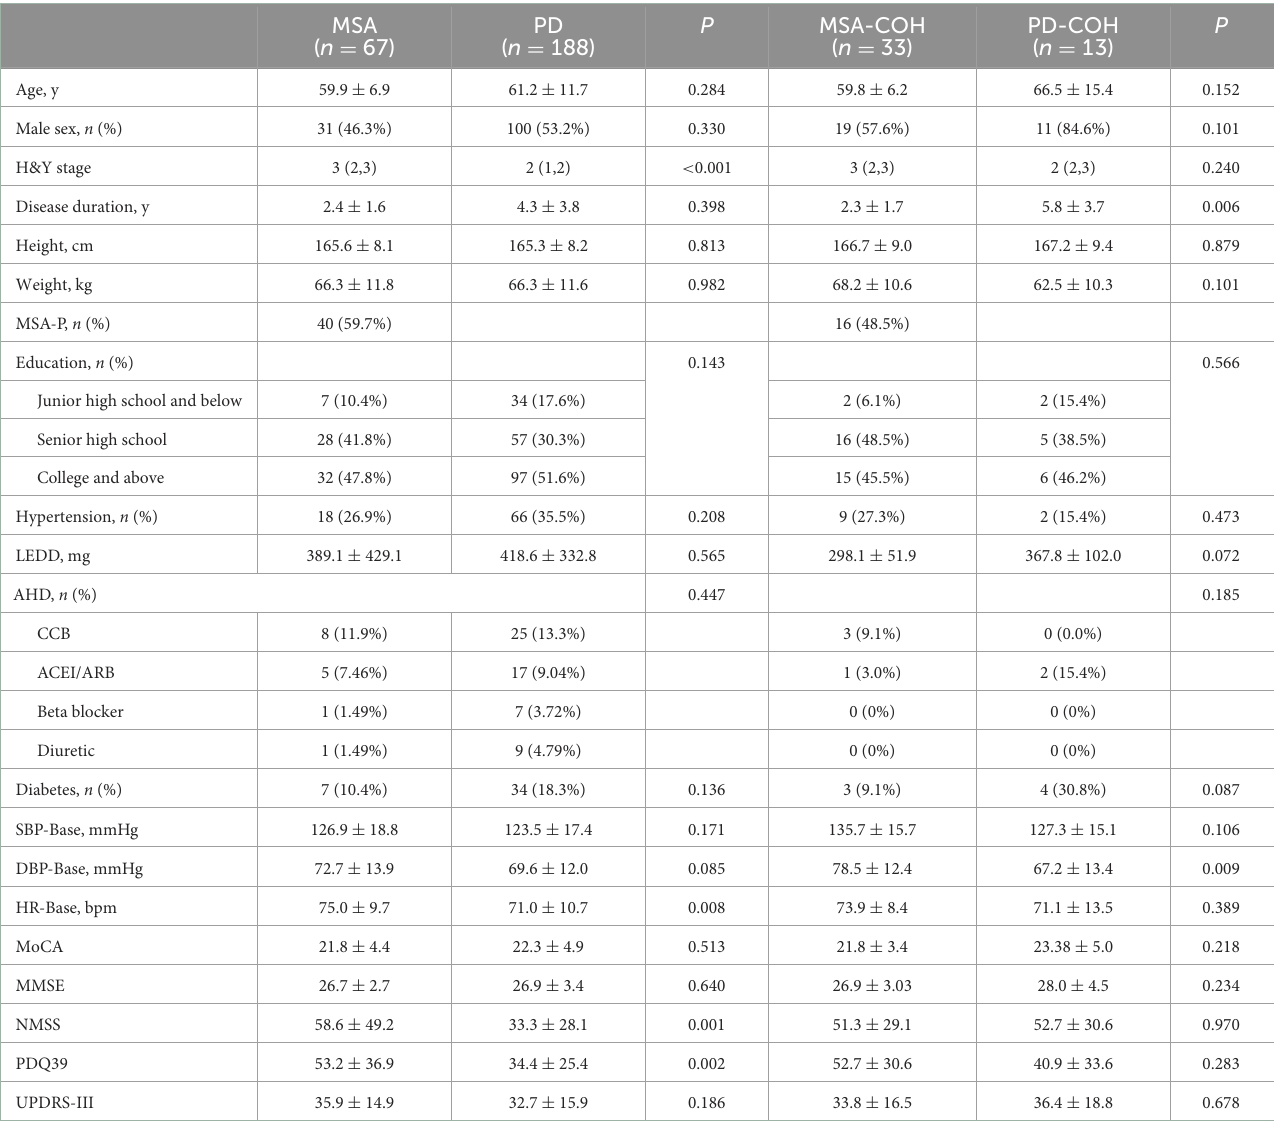
TABLE 1 Demographic and clinical characteristics of PD and